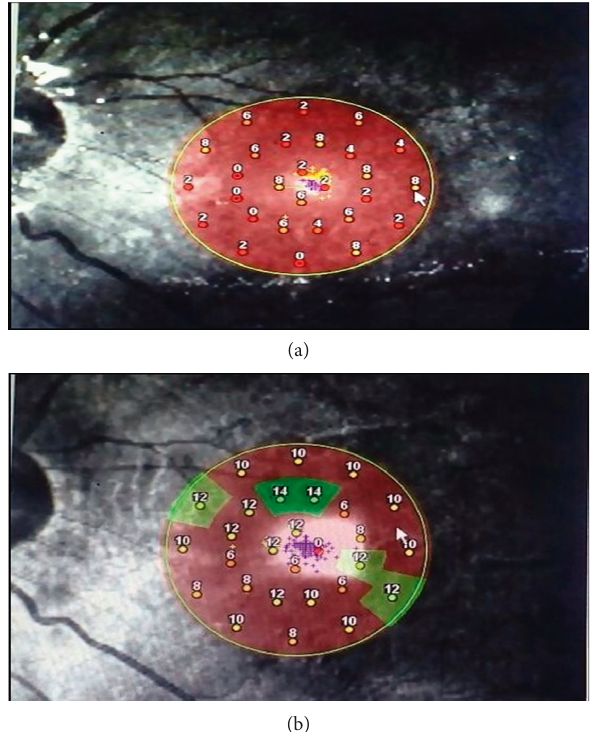
Figure 1: (a, b) Microperimetry polar 3–12 ° test (patient No. 5, left eye) superimposed on scanning laser ophthalmoscope infrared image. The test points were arranged within the macula showing the sensitivity values in 3 concentric circles centered on the fovea (a) with a preoperative mean retinal sensitivity of (4dB) and (b) with a postoperative mean retinal sensitivity of